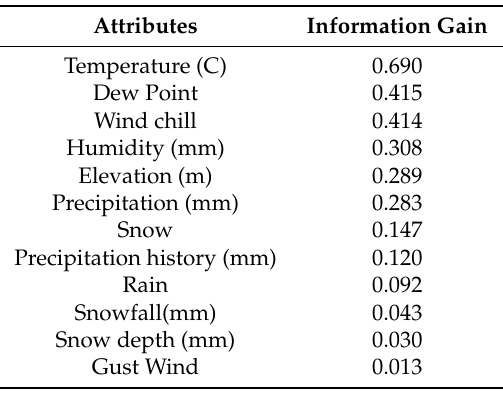
Table 1. Information gain of input attributes.